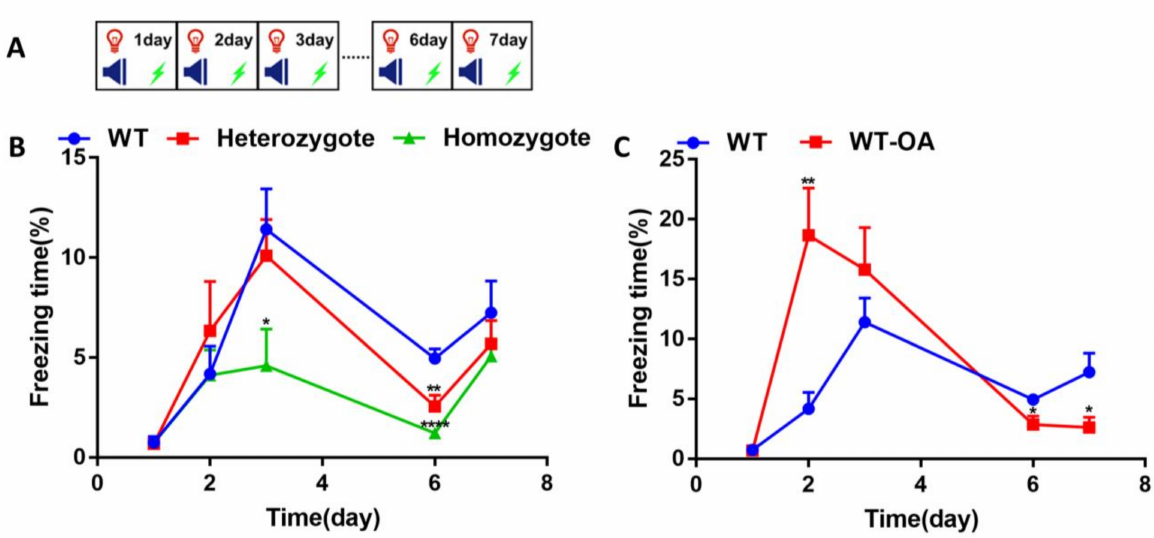
Figure 3. Loss of BChE weakened the re-arousal of fear conditioning memory of 10-month-old mice. ( A ) Experimental design for the re-arousal of fear conditioning training. The freezing time was measured during 180s of adaptation and 2 cycles of CS+US. ( B ) The percentage of freezing time of wild-type (WT), BChE heterozygous, and BChE KO mice. ( C ) The percentage of freezing time of ( R )-bambuterol administered orally (WT-OA). n = 7–8 mice per group. Data were represented as mean ± SEM. * p < 0.05; ** p < 0.01; **** p < 0.0001; vs. WT group, one-way ANOVA followed by Tukey’s post hoc test (for B ) and unpaired t test (for C